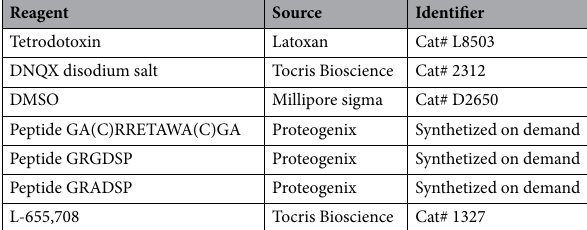
Table 1. Sources and catalog numbers of crucial reagents